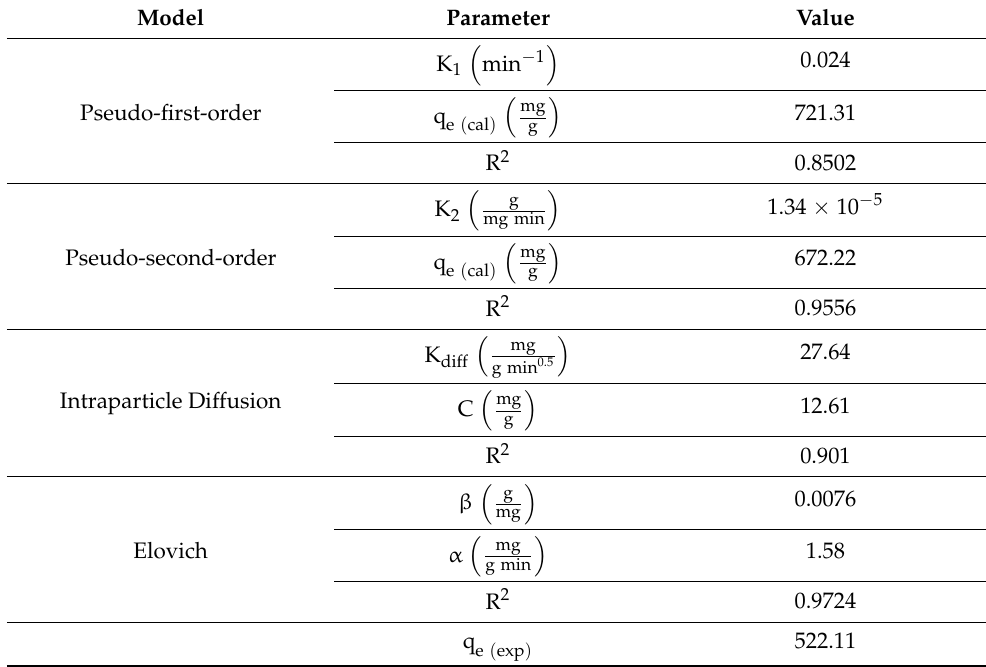
Table 1. Calculated parameters from different kinetic study models of heparin adsorption over ZIF-8.